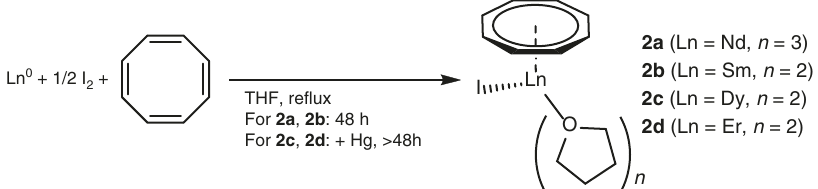
Fig. 3 General synthetic procedure part 1. Synthesis of the cyclooctatetraene-complexes [( η 8 -C 8 H 8 )LnI(thf) n ] (Ln = Nd ( 2a ), Sm ( 2b ), Dy ( 2c ), Er ( 2d ))